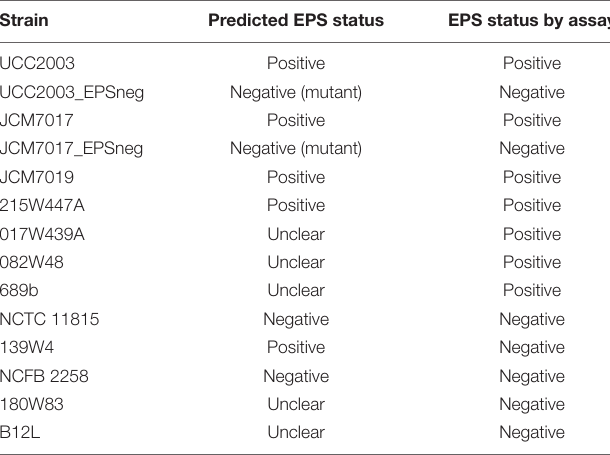
TABLE 3 | EPS status of B. breve